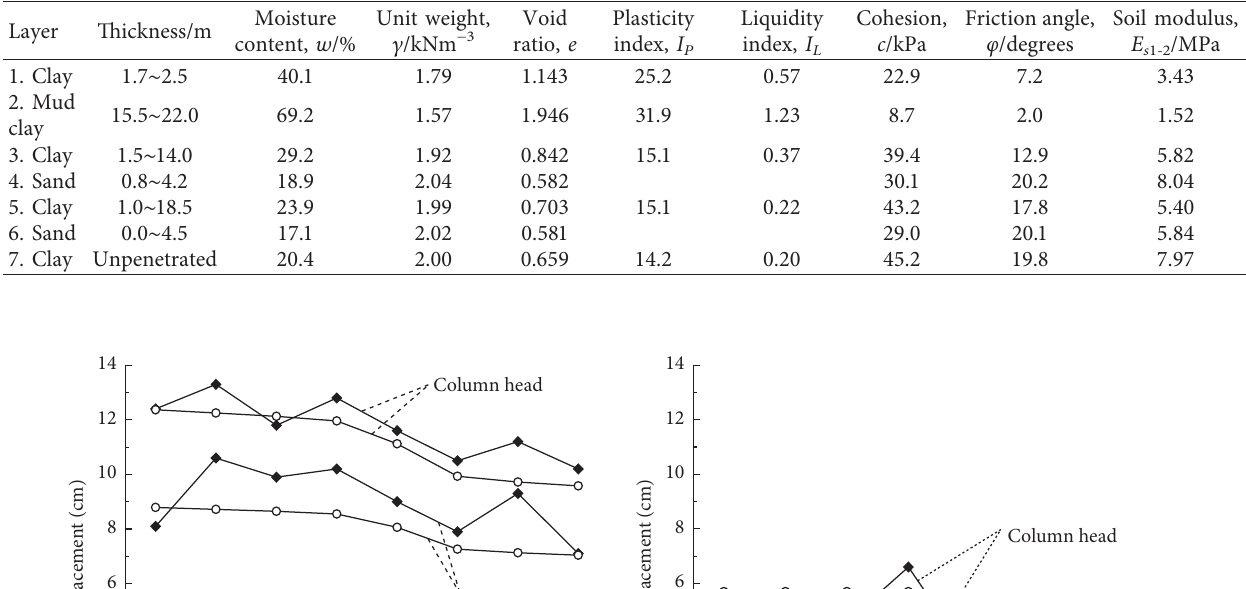
Figure 8: Displacement of columns of SX Bridge Table 1: Physical and mechanical properties of the soils at the interchange site.